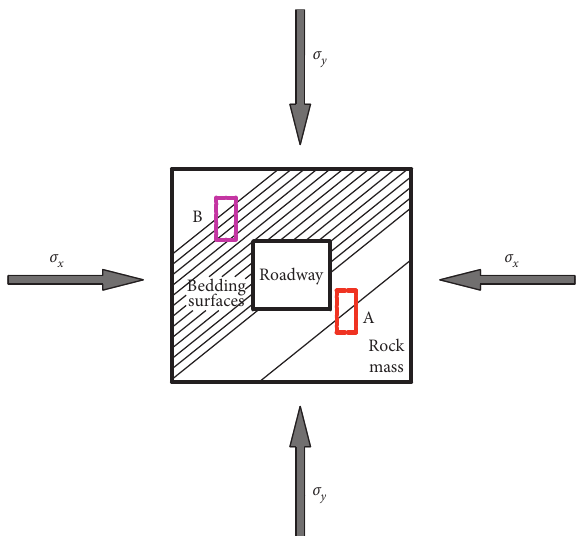
Figure 1: Composition of stratiform surrounding rock. “A” repeats a single structure plane. “B” indicates a single group of structure